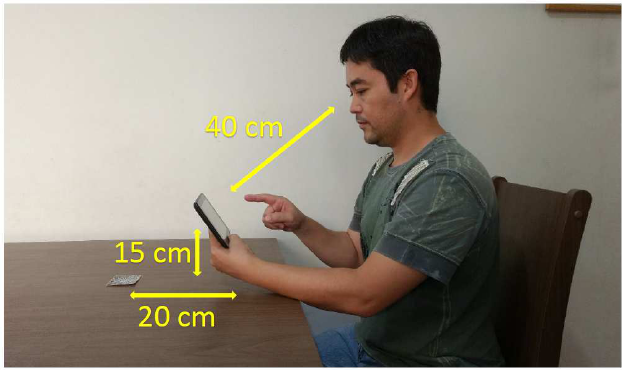
Figure 3. Environment of the experiments